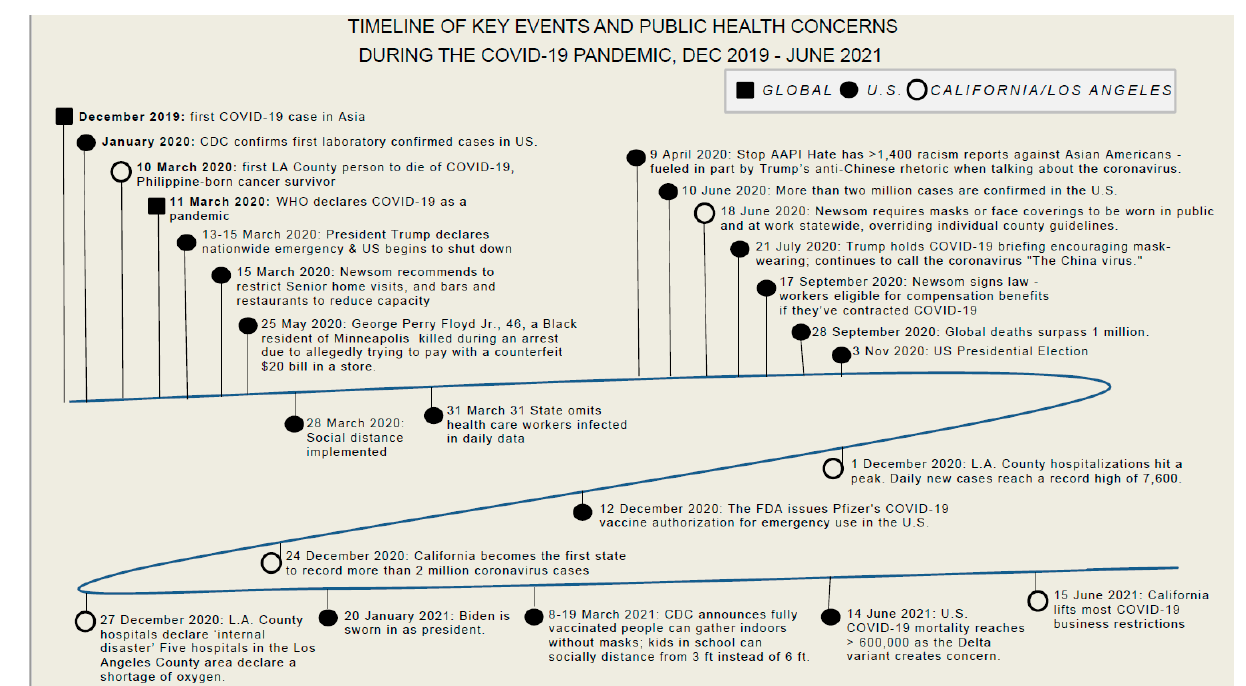
Figure 1. Timeline of key events of Public health Concerns during the COVID-19 pandemic, December 2019–June 2021.